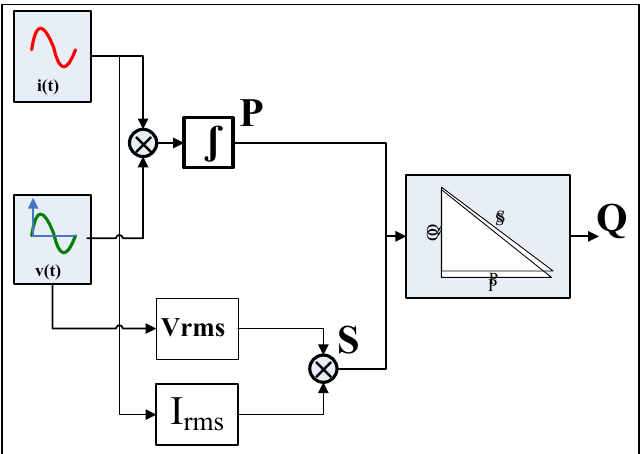
Figure 3. Power triangle approach for reactive power